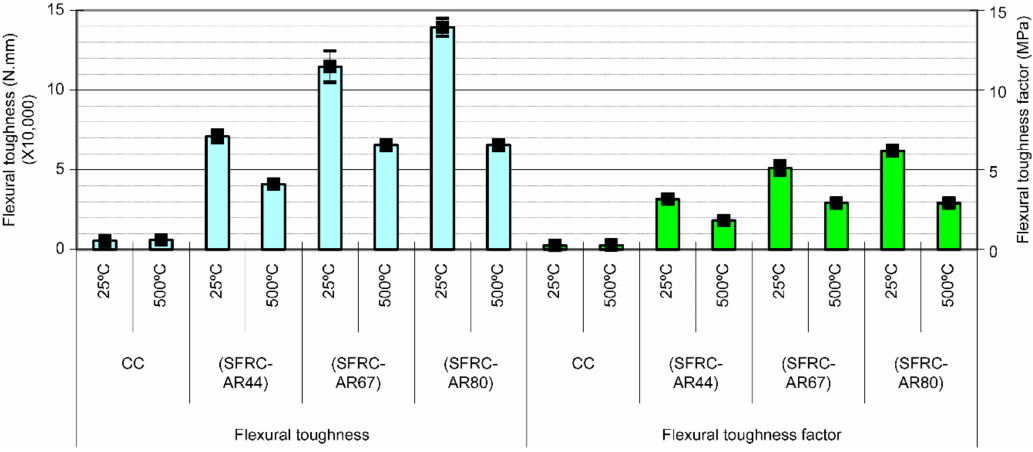
Figure 8. Flexural toughness and flexural toughness factor values obtained for various concrete